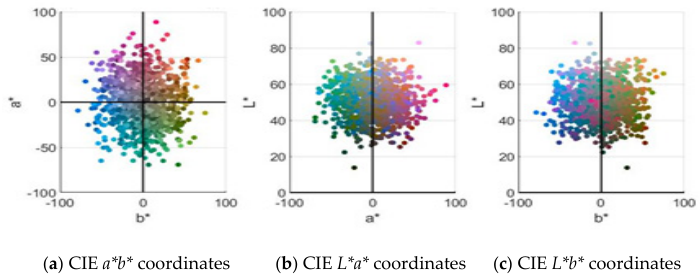
Figure 6. CIE L*a*b* transformation, combining two coordinates each time.